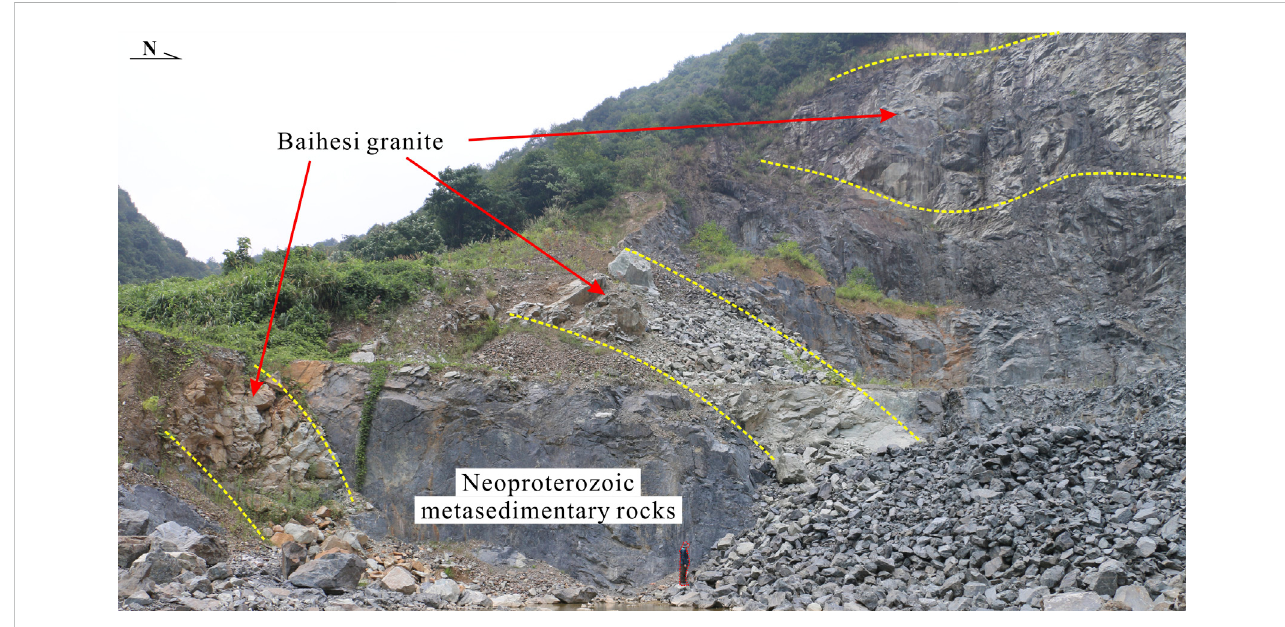
FIGURE 3 Field photo showing the emplacement characteristic of